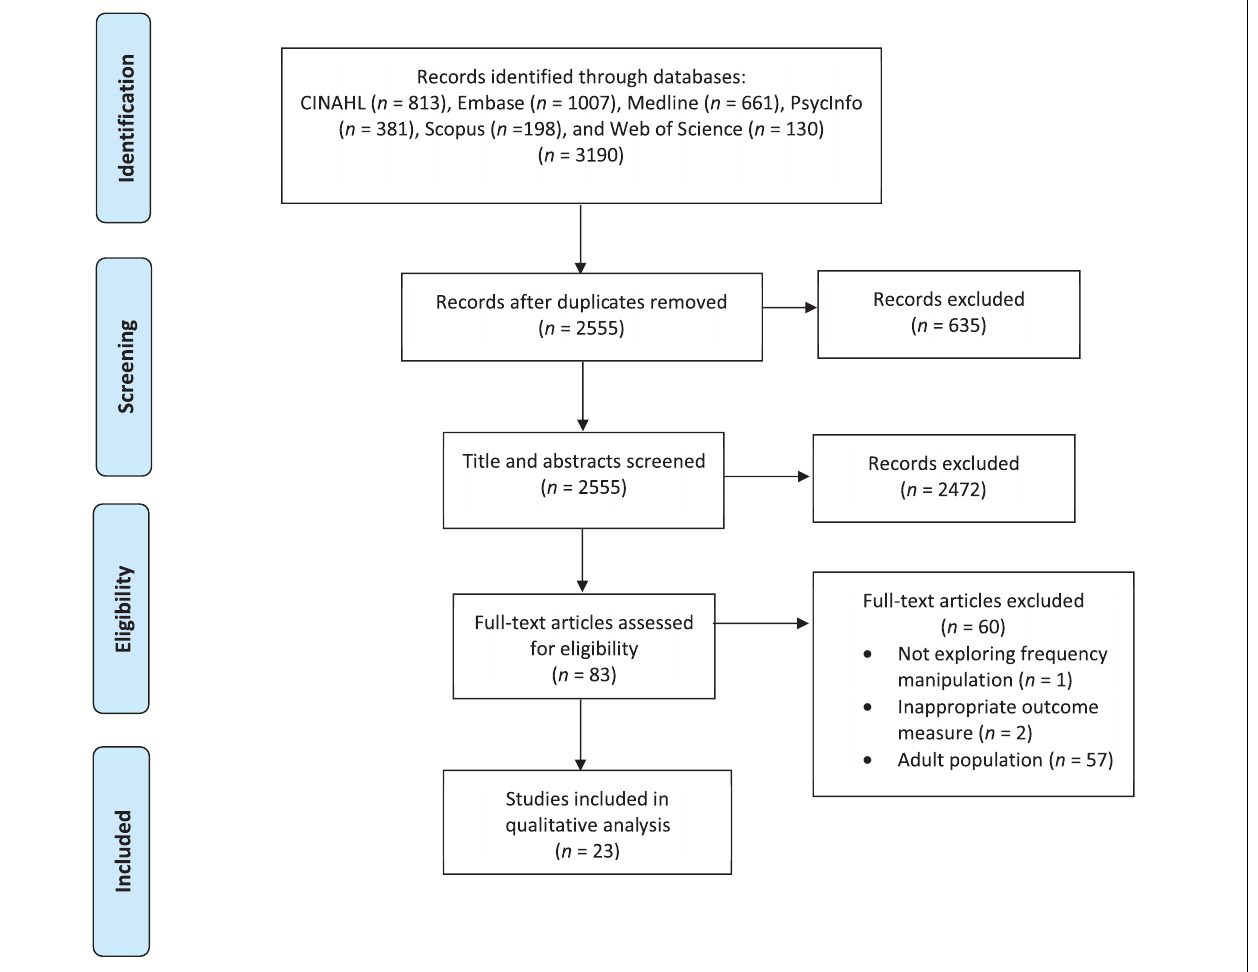
FIGURE 1 | PRISMA diagram of the systematic review of articles for